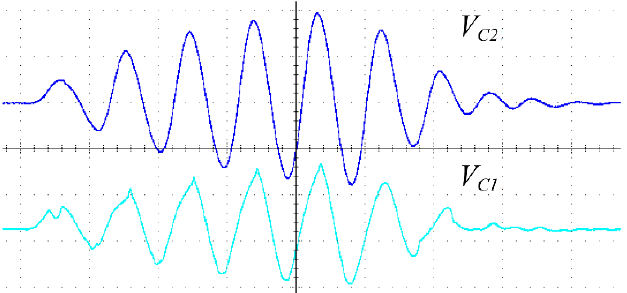
Figure 14. Experimental waveforms (100 nS/div 100 V/div) of resonant capacitor voltage V C2 (blue